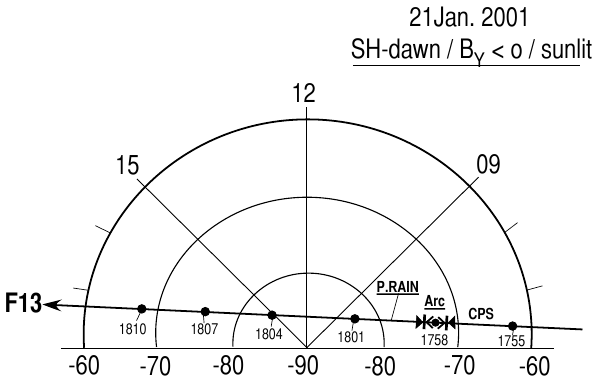
Fig. 21. DMSP F13 track across the polar cap in the Southern Hemi- sphere. Precipitation/Birkeland current/convection regimes marked in the figure are: (1): P.RAIN; (2) P.RAIN and FC 2 and C1 current; (3): morning arcs and C2/R1 currents; (4): CPS and R2 current. The event category is: SH-dawn/ B y < 0